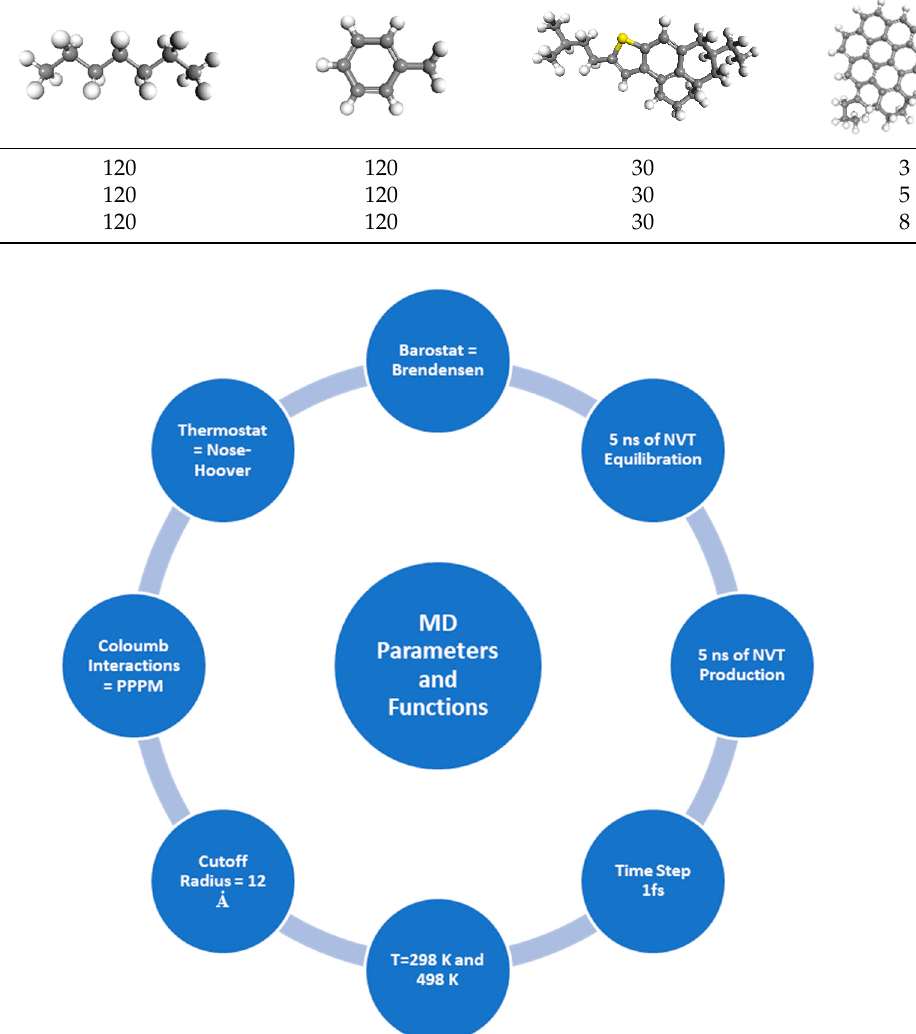
Figure 1. Parameters and MD simulation functions.